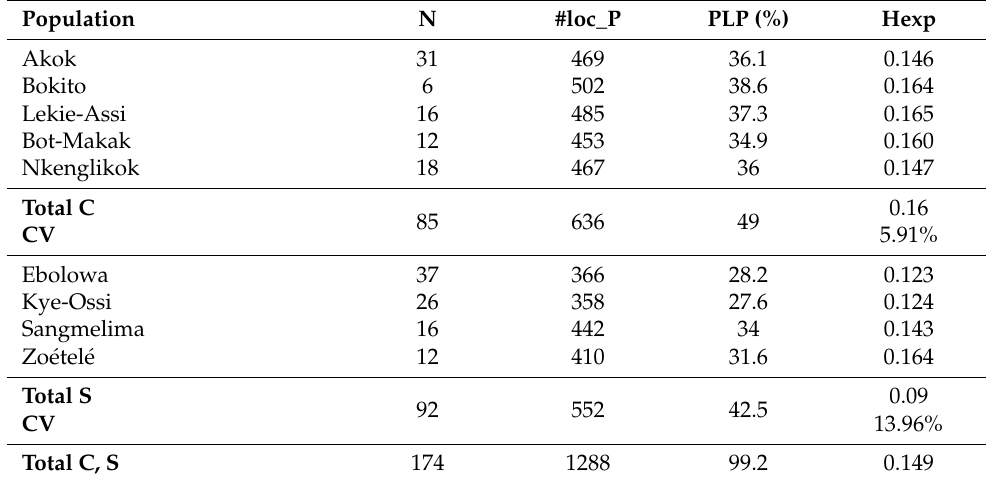
Table 5. Genetic diversity measures for 9 populations of G. kola .